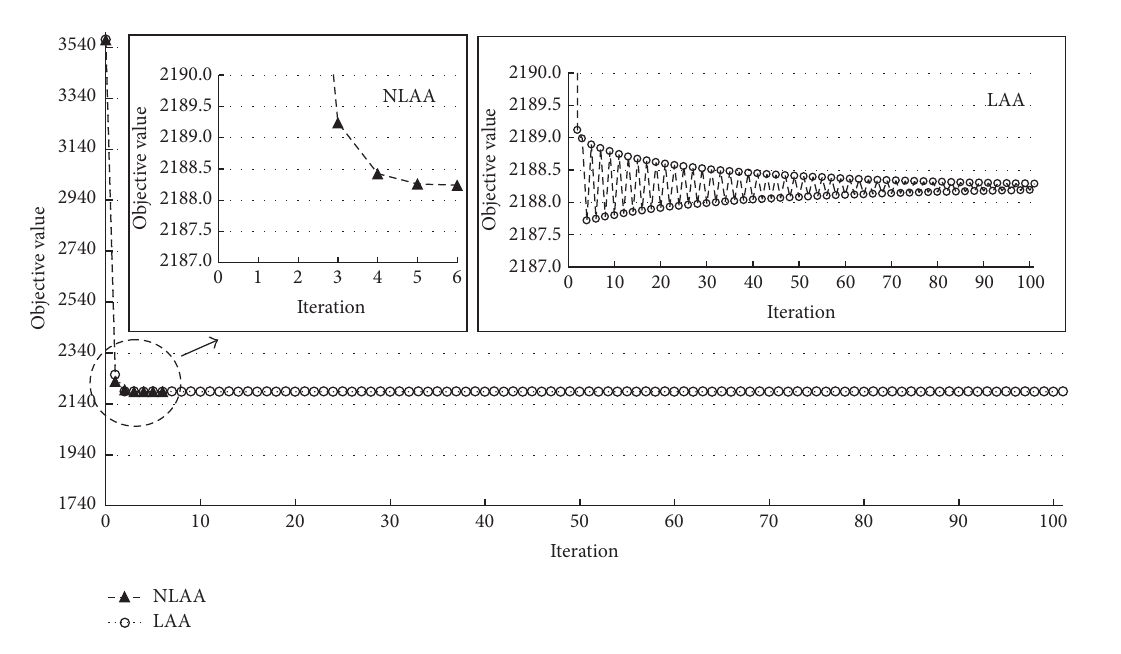
Figure 3: The convergence curves of LAA and NLAA in Example